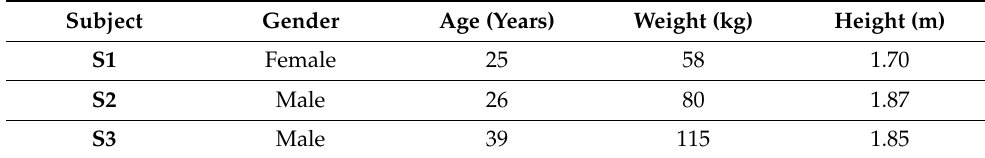
Table 1. Subjects’